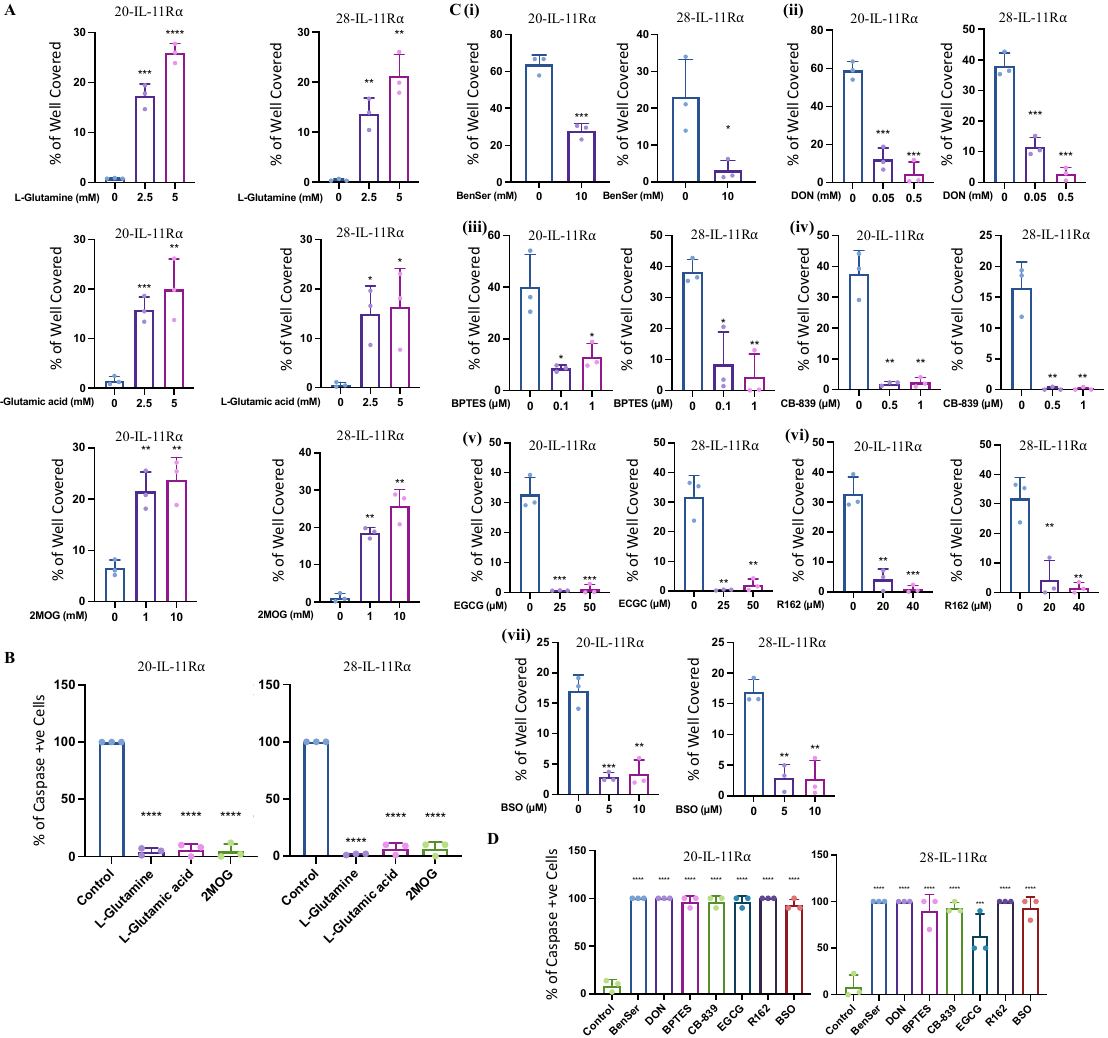
Figure 3. IL-11R α expression promotes survival through glutaminolysis. #20-IL-11R α and #28-IL-11R α cells were cultured in glucose-free and glutamine-free media ± L-glutamine, L-glutamic acid or 2-MOG for 48 h and evaluated for ( A ) survival using the cell viability assay (n = 3, mean ± SD, where * indicates p < 0.05, ** indicates p < 0.01, *** indicates p < 0.001 and **** indicates p < 0.0001) and ( B ) percentage of apoptotic cells (active caspase3/7 fluorescence) (n = 3, mean ± SD, where **** indicates p < 0.0001). #20-IL-11R α and #28-IL-11R α cells were cultured in glucose-free, glutamine-containing media ( C ) ( i ) ± BenSer, ( ii ) DON, ( iii ) BPTES, ( iv ) CB-859, ( v ) EGCG, ( vi ) R162 and ( vii ) BSO for 48 h and evaluated for ( C ) survival using the cell viability assay (n = 3, mean ± SD, where * indicates p < 0.05, ** indicates p < 0.01, *** indicates p < 0.001) and ( D ) percentage of apoptotic cells (active caspase3/7 fluorescence) (n = 3, mean ± SD, where *** indicates p < 0.001 and **** indicates p < 0.0001). 2.4. IL-11R α -Driven Migration and Invasion Is Glutamine-Dependent but Glucose-Independent As # 20-IL-11R α and #28-IL-11R α cells demonstrated enhanced survival in glu- cose-free, glutamine-containing media compared to parental controls, we next deter- mined whether these cells also displayed differential migratory and invasive capabilities in the absence of glucose and/or glutamine. The degree of # 20-IL-11R α and #28-IL-11R α